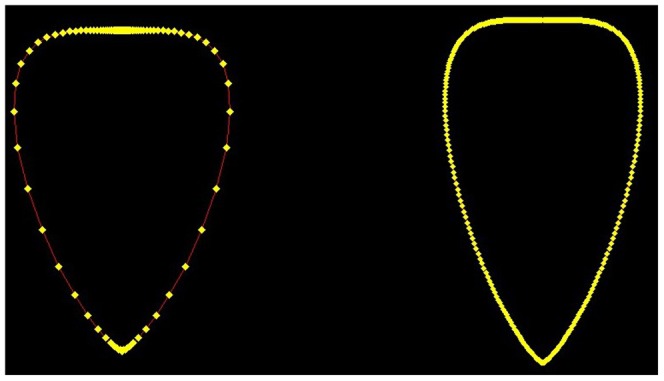
The g(t)-points of a path curve (λ = 0.3), with t ∈ [−20, 20].Left: with a step size of 0.4: t = 0.4·i, i ∈ IN. Right: with a step size of 0.05: t = 0.05·i, i ∈ IN.